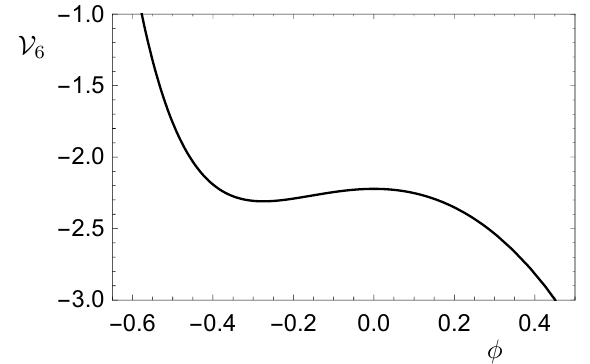
( (cid:30) ) of the model in D = 6 dimensions, as a function of the one V 6